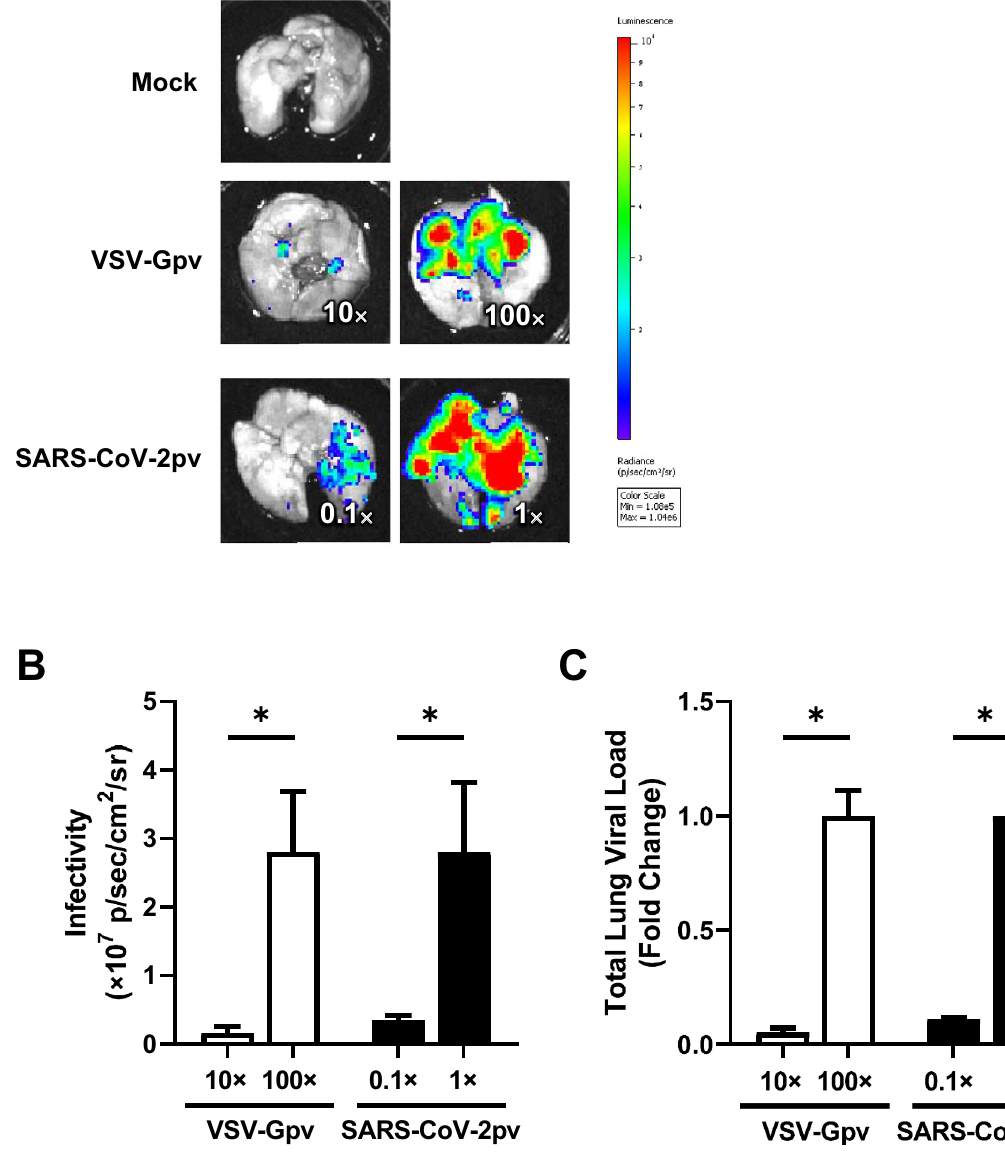
Figure 2. Dose-dependent infectivity after inoculation of the pseudotyped virus. ( A ) Representative lung imaging after inoculation of mock (top), VSV-Gpv (middle), and SARS-CoV-2pv (bottom). The numbers indicate the concentration ratio from the original viral solution (7.1 × 10 6 RLU/hamster). ( B ) Infectivity after inoculation of VSV-Gpv (n = 3) and SARS-CoV-2pv (n = 3). Data are expressed as the mean of sum luminescence of the front and back. ( C ) Viral loads in lungs evaluating VSV N expression. Data are expressed as the fold change from the higher concentration (VSV-Gpv; n = 2, SARS-CoV-2pv; n = 3). All experiments were performed 24 h after inoculation. Error bars are the SEM. * indicates p <